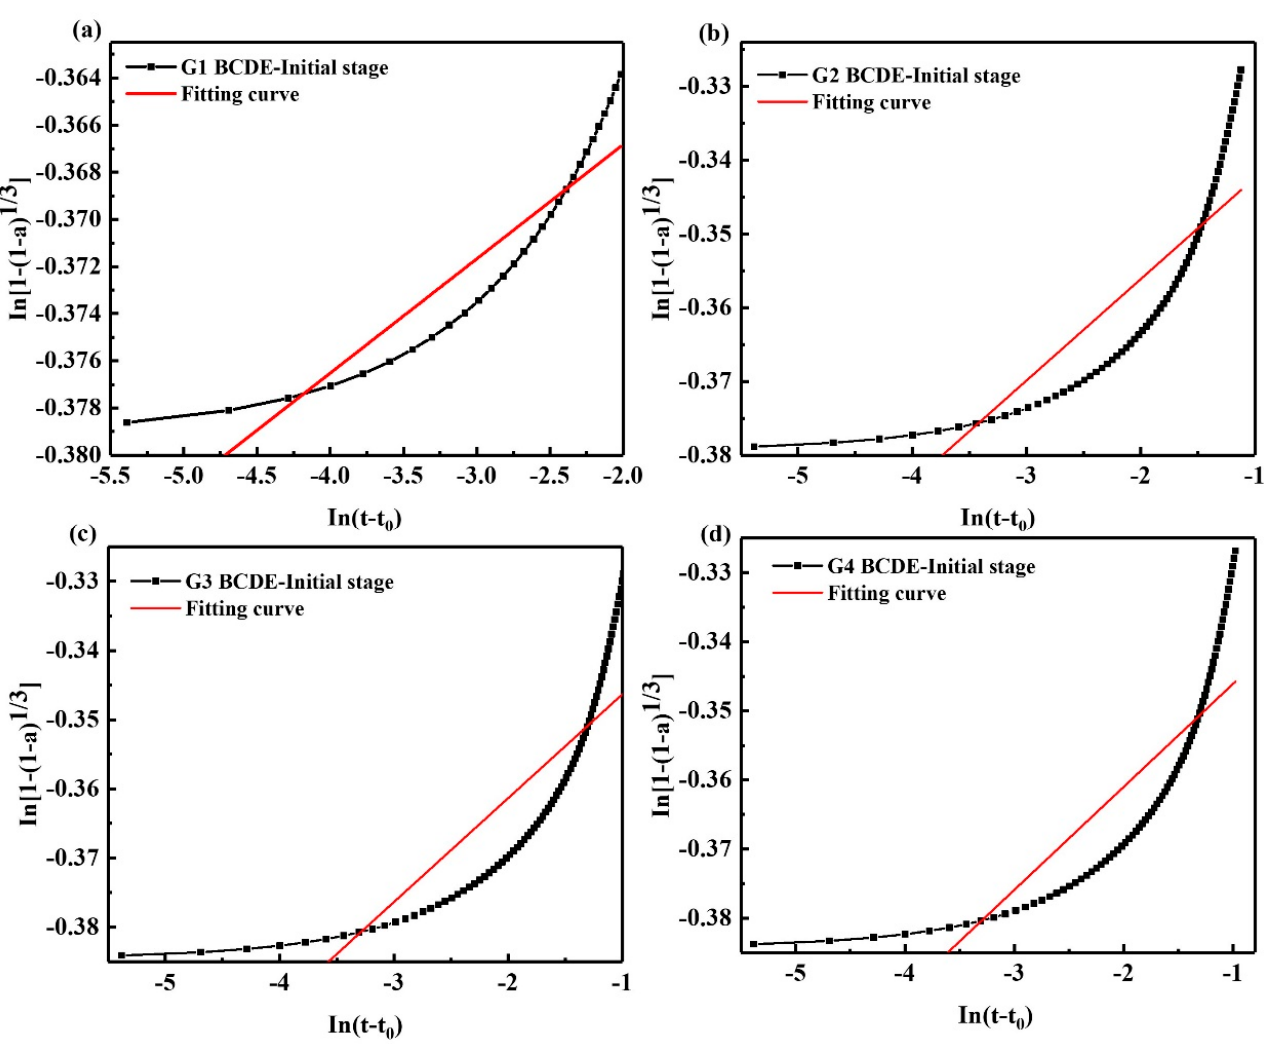
Figure 6. Kondo equation piecewise fitting hydration acceleration initial stage (BCDE-initial stage); ( a ) G1, ( b ) G2, ( c ) G3, ( d ) G4. Table 5. Results of Kondo equation piecewise fitting hydration acceleration initial stage.